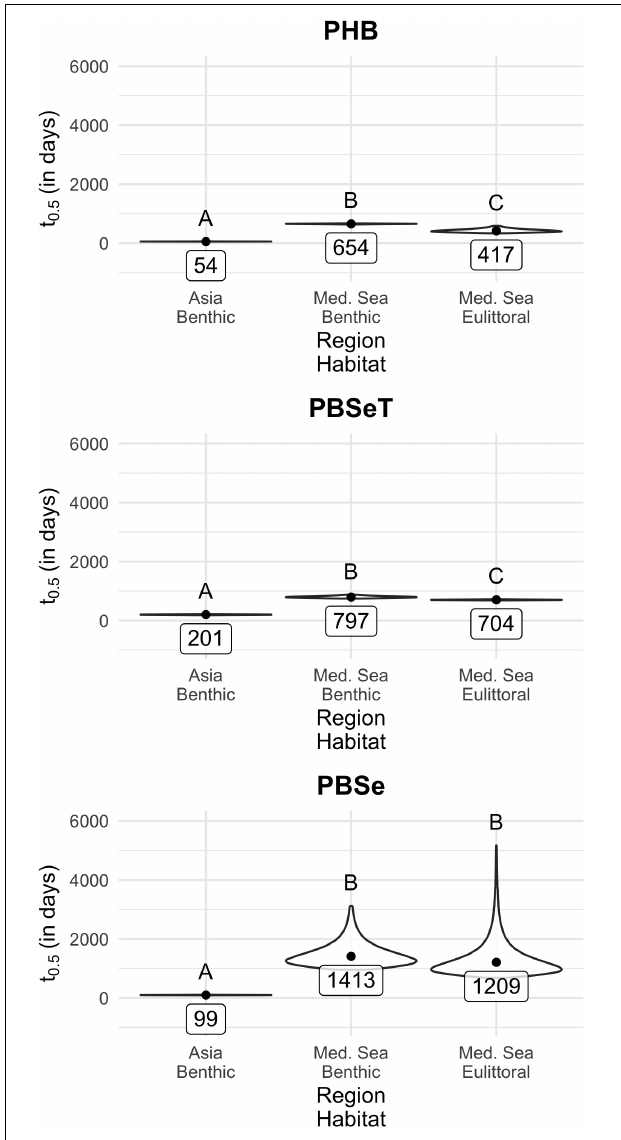
FIGURE 7 | Comparison of the disintegration half-lives t 0 . 5 of PHB, PBSeT, and PBSe from field experiments in tropical SE Asia and the Mediterranean Sea: Monte Carlo simulations of half-life for tested polymers in the benthic (seafloor sediment-seawater interface) in Asia and the Mediterranean Sea and in the eulittoral (beach scenario) in the Mediterranean Sea. Shown is the distribution of the centered 95 percentiles of the simulations as violin plots. The dot in the center of each violin plot represents the half-life as calculated from the model coefficient and its value is given in the box below. Letters above the violin plot represent the results of the multiple comparisons. Different letters indicate significantly different groups (i.e., Holm-adjusted p -value below α =